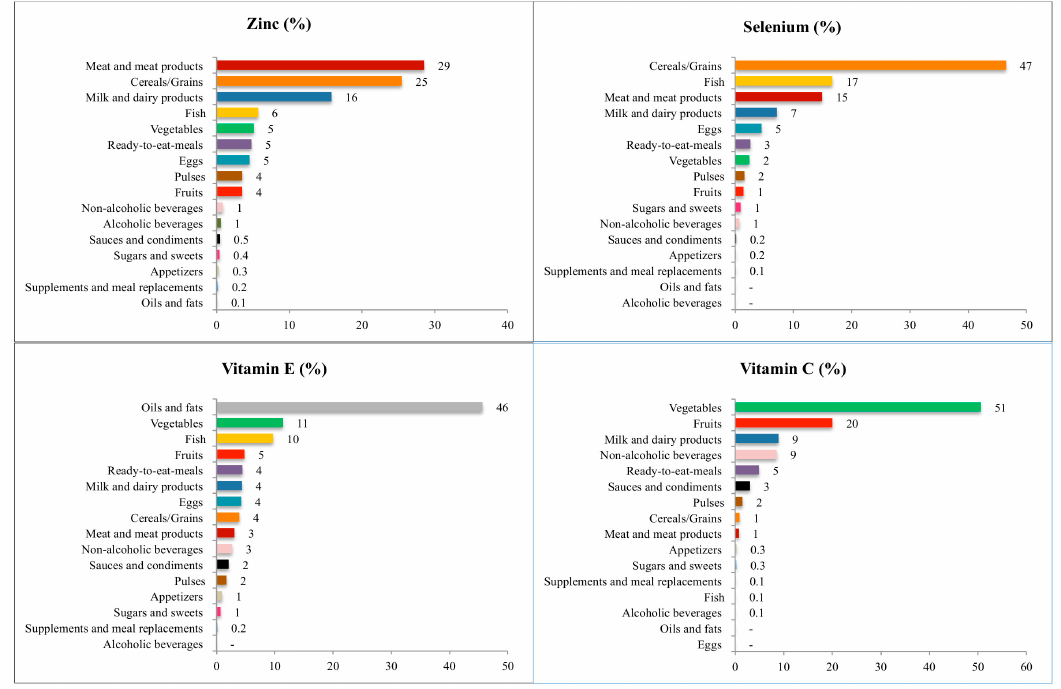
Figure 1. Contribution of food sources to the daily zinc, selenium, and vitamins E and C intake in the ANIBES Study population.